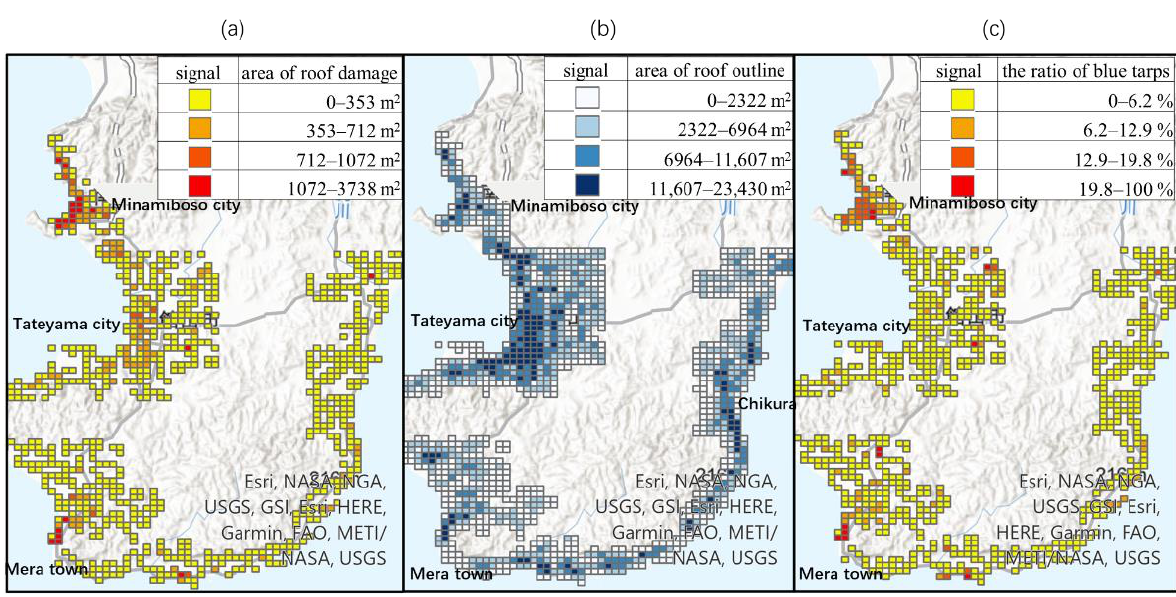
Figure 17. Distribution of roof damage in southern Chiba Prefecture. ( a ) the total area the detected roof damage in each mesh. ( b ) the total area of the detected roof outline. ( c ) the distribution of the ratio of roof damage.